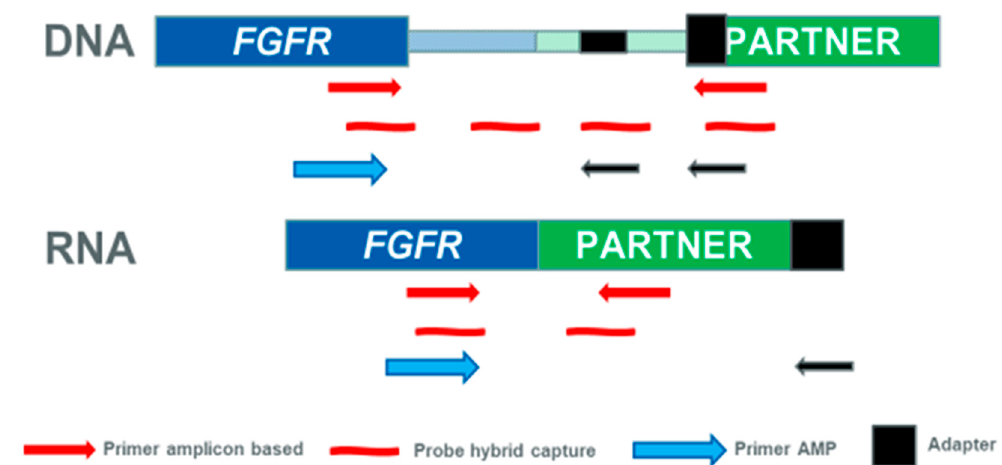
Figure 1. DNA- and RNA-targeted sequencing approaches for detecting FGFR fusions. Hybrid capture methods use sequence specific probes complementary to a specific region of interest that are longer than PCR primers, whereas amplicon-based enrichment methods use primers specific to known fusion partners. The anchored multiplex PCR approach uses gene-specific primers